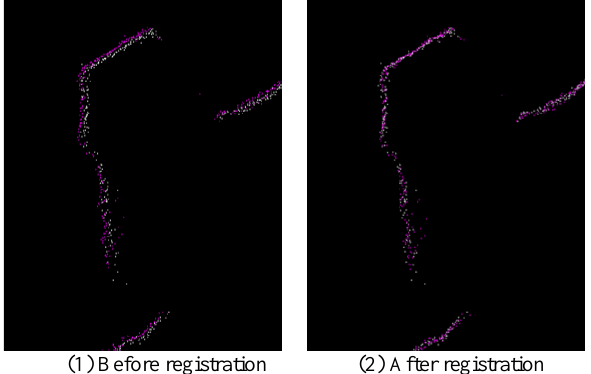
Figure 3. Point Clouds of a Slope Failure